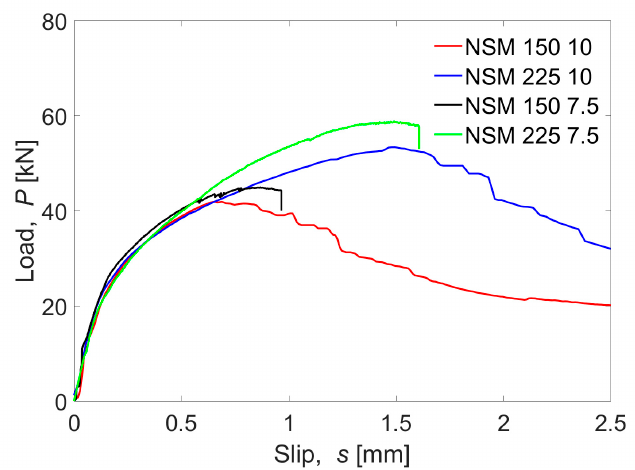
Figure 10. Experimental results from the single shear tests.